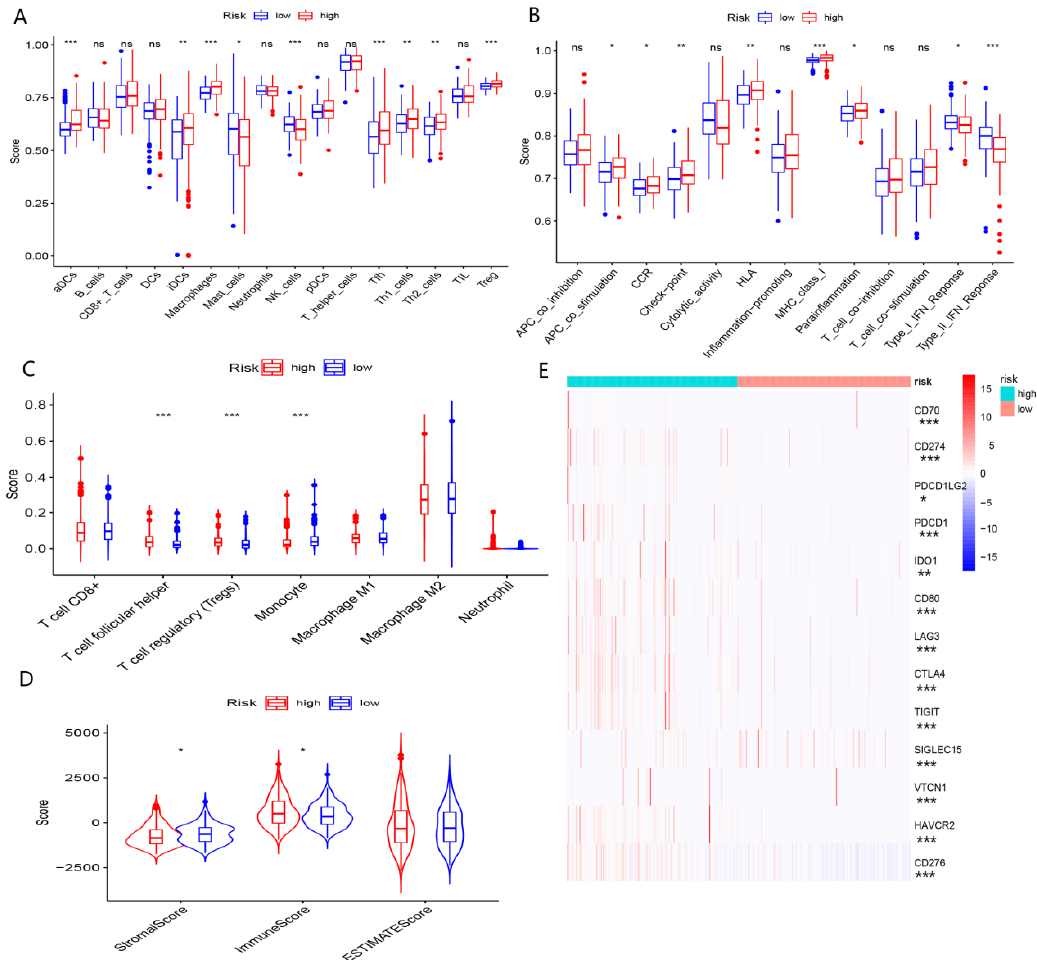
Figure 10. Immune profile analyses. ( A ) Comparison of immune cell infiltration between high- and low-risk groups using the ssGSEA algorithm. ( B ) Comparison of immune function between the high- and low-risk groups using the ssGSEA algorithm. ( C ) Comparison of immune cell infiltration between the high- and low-risk groups using the CIBERSORT algorithm. ( D ) Comparison of components in TME between the high- and low-risk groups. ( E ) Comparison of immune checkpoint in the high- and low-risk groups. (*, **, ***, and ns representing p < 0.05, p < 0.01, p < 0.001, and not statistically significant,